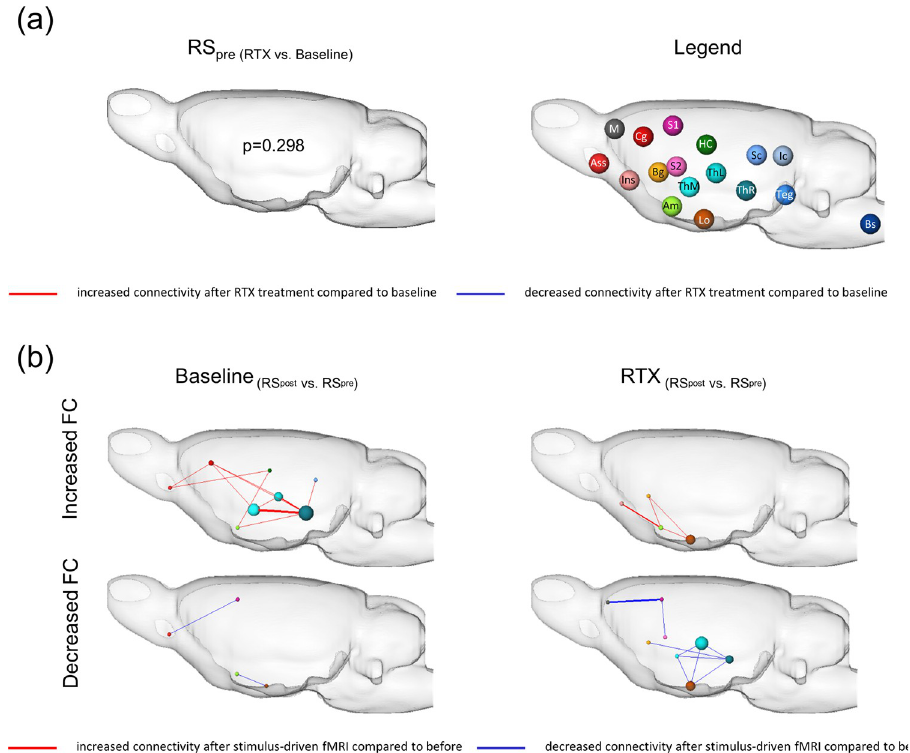
Fig 7. Impact of thermal stimuli on RS functional connectivity with and without peripheral TRPV1-signaling. No significant differences could be found between baseline and RTX RS-networks comparing the RS measurement that took place before the stimulus-driven stimulation ((a), RS pre, p = 0.298). In contrast, the stimulation left significant imprints on RS-networks (RS pre compared to RS post ) for both groups (b). At baseline, animals showed distinct changes in RS FC after being subjected to the nociceptive stimulus-based fMRI session: increased FC (red edges) could be shown for thalamus, association cortex, amygdala and hippocampus, whereas reduced FC (blue edges) was found mainly in cortical and amygdala-hypothalamic regions. After RTX-treatment, enhanced FC could be found only in limbic regions (Lo, Am, BG, Ins). Reduced FC was now more prominent specifically in thalamus, but also found, alike baseline, in cortical and hypothalamic areas. Different functional groups are distinguished by the node colors. Node size represents number of significantly different connections each node has to others. Thickness of edges represents strength of connection (sum of Pearson r of all significantly differing connections). Statistical significance was calculated using NBS (a) and paired t-Test, permutation corrected p � 0.05 (b). (n Baseline = 18; n RTX = 9). Abbreviations: Am: amygdala; Ass: association cortex; BG: basalganglia; Bs: brainstem structures; Cg: cingulate cortex; HC: hippocampus; Ic: inferior colliculi; Ins: insular cortex; Lo: limbic output/hypothalamus; M: motor cortex; S1/S2: primary/secondary somatosensory cortex; Sc: superior colliculi; Teg: Tegmentum; thM/L: medial/lateral thalamus; ThR: other thalamic nuclei.